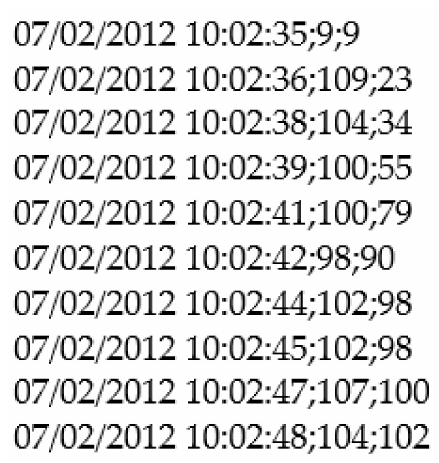
Figure 2. The data format of the TraceBase